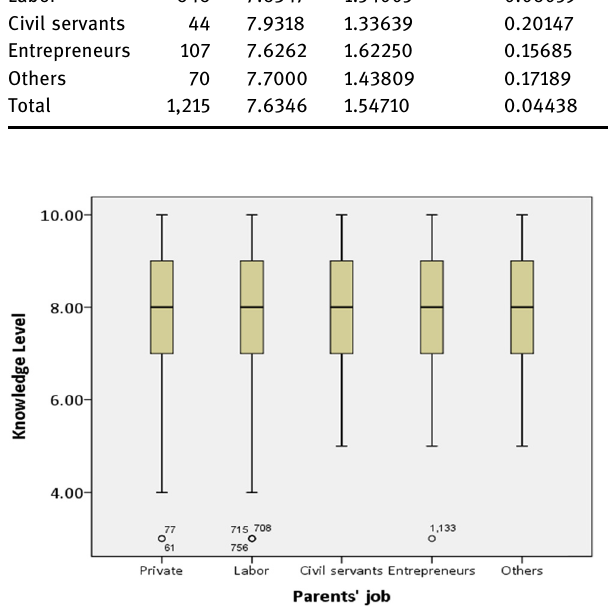
Figure 5: Student ’ s knowledge level by parent ’ s job.